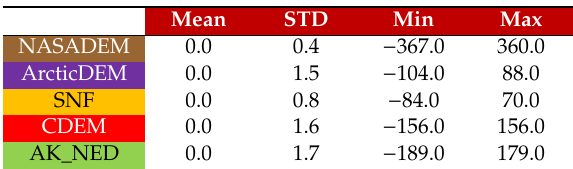
Table 10. Horizontal Geodetic Improvement, in